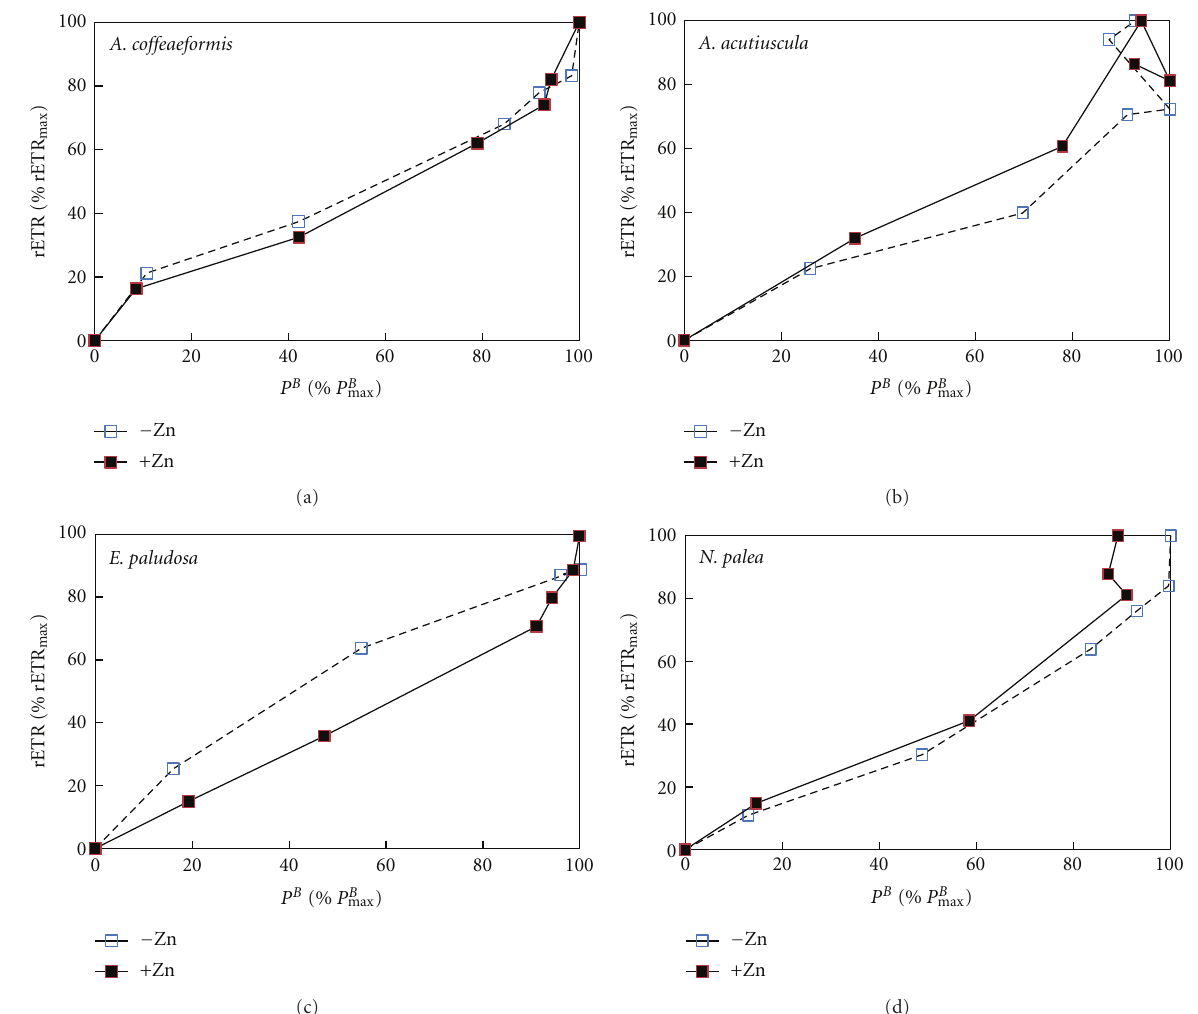
Figure 4: Relationship between the relative intensity of rETR and the relative intensity of P B in Amphora co ff eaeformis, Amphora acutiuscula, Entomoneis paludosa, and Nitzschia palea grown in the absence ( (cid:2) ) or the presence ( (cid:4) ) of a Zn